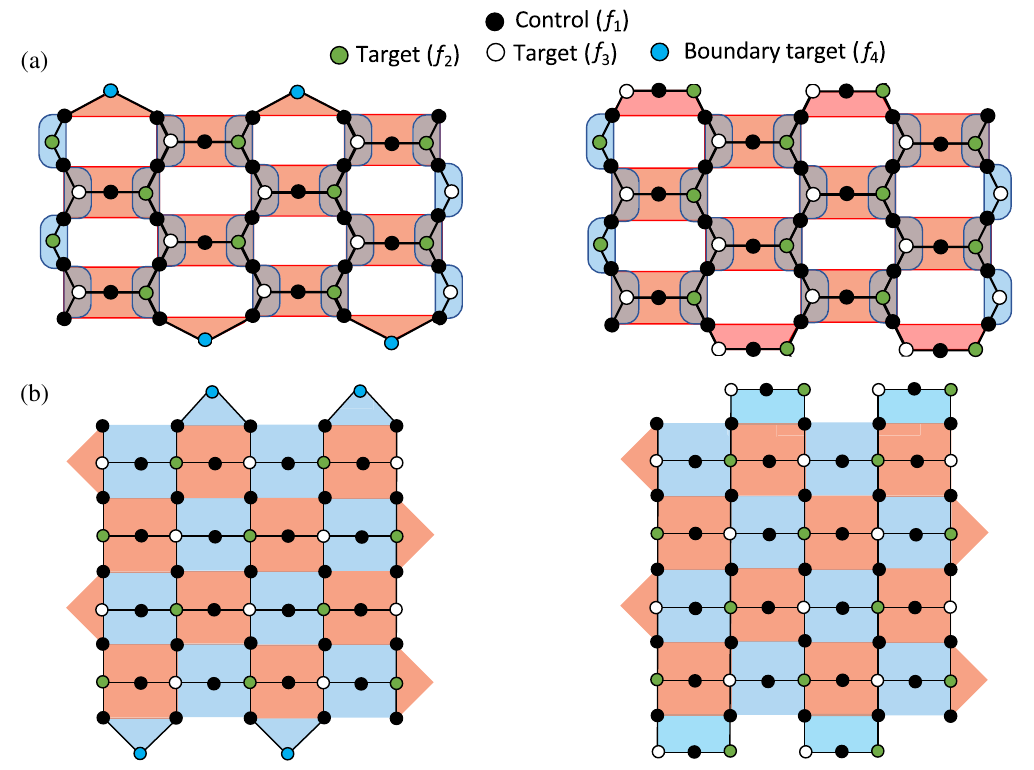
FIG. 10. Frequency assignments of the heavy-hexagon code (a) and the heavy-square code (b). Solid black lines indicate the actual connections and CNOT gates in the fabricated superconducting device. The black dots indicate control qubits, while the other three colors indicate target qubits. The original heavy-hexagon and heavy-square codes on the left panels feature three distinct frequencies in the bulk and an additional frequency on the boundary, while the modified codes on the right panels remove the extra frequencies (white dots) on the